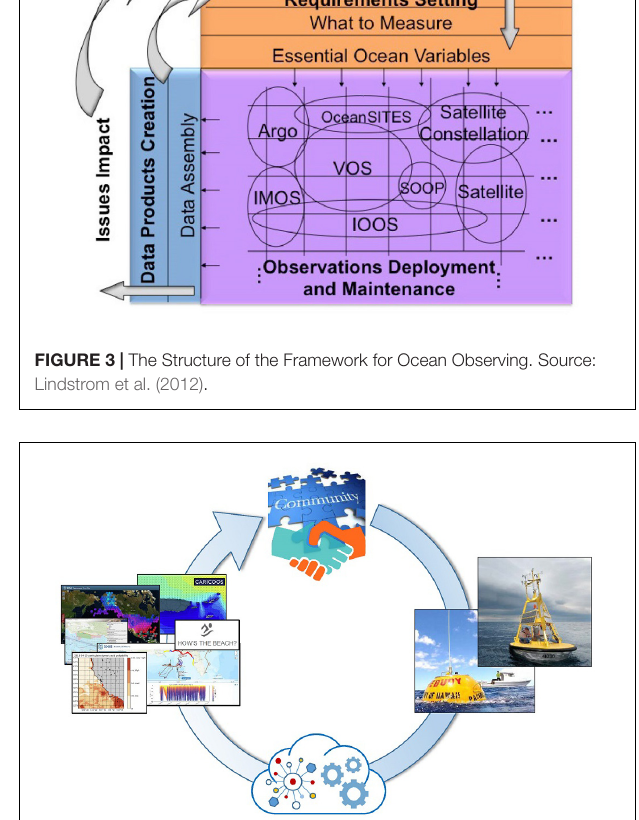
FIGURE 4 | The process by which IOOS RAs produce quality information products based on ocean observations to meet stakeholder needs. The process begins with stakeholder outreach discussions to determine what variables and measuring technologies are needed. Data are ingested into RA systems where they are quality controlled and distributed through regional portals and data access services. Data products developed by the RAs are tuned to stakeholder needs, and the RAs receive feedback through continued stakeholder engagements. Wave buoy source: Pacific Islands Ocean Observing System (PacIOOS); Meteorological buoy source: